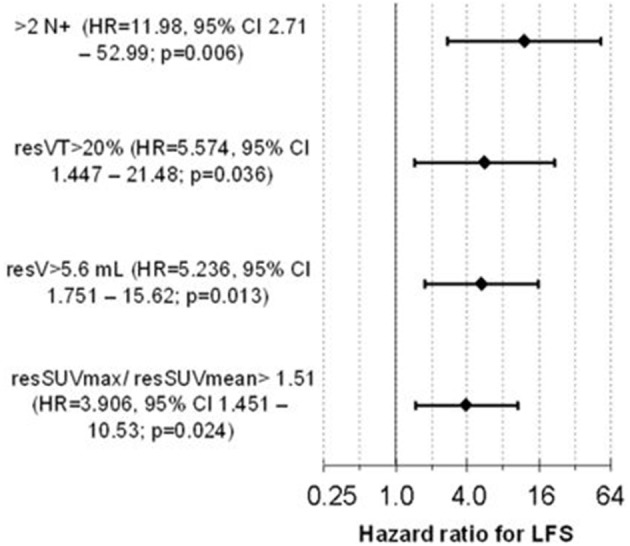
The Cox proportional hazard model for laryngectomy-free survival (LFS) developed in responders (p = 6.28 × 10–4) contains 4 independent significant covariates and predicts the LFS, overall (OS), and tumor- specific survival (TSS) of responders Forrest plot for the four covariates in the multivariate Cox model (1) suspect positive neck nodes (N+) ≤2 vs. >2, (2) residual volume of the primary tumor resVT ≤20 vs. >20%, (3) residual total tumor volume in CT-based volumetry resV≤5.6 vs. >5.6 ml, and (4) the ratio of the residual standard-uptake value maximum and the residual standard-uptake value mean resSUVmax/resSUVmean≤1.51 vs. >1.51. Fifty two consecutive patients with advanced laryngeal and hypopharyngeal carcinoma in the phase II larynx preservation trial DeLOS-11 treated in the University Hospital Leipzig (31); permission for reuse kindly provided by Elsevier.